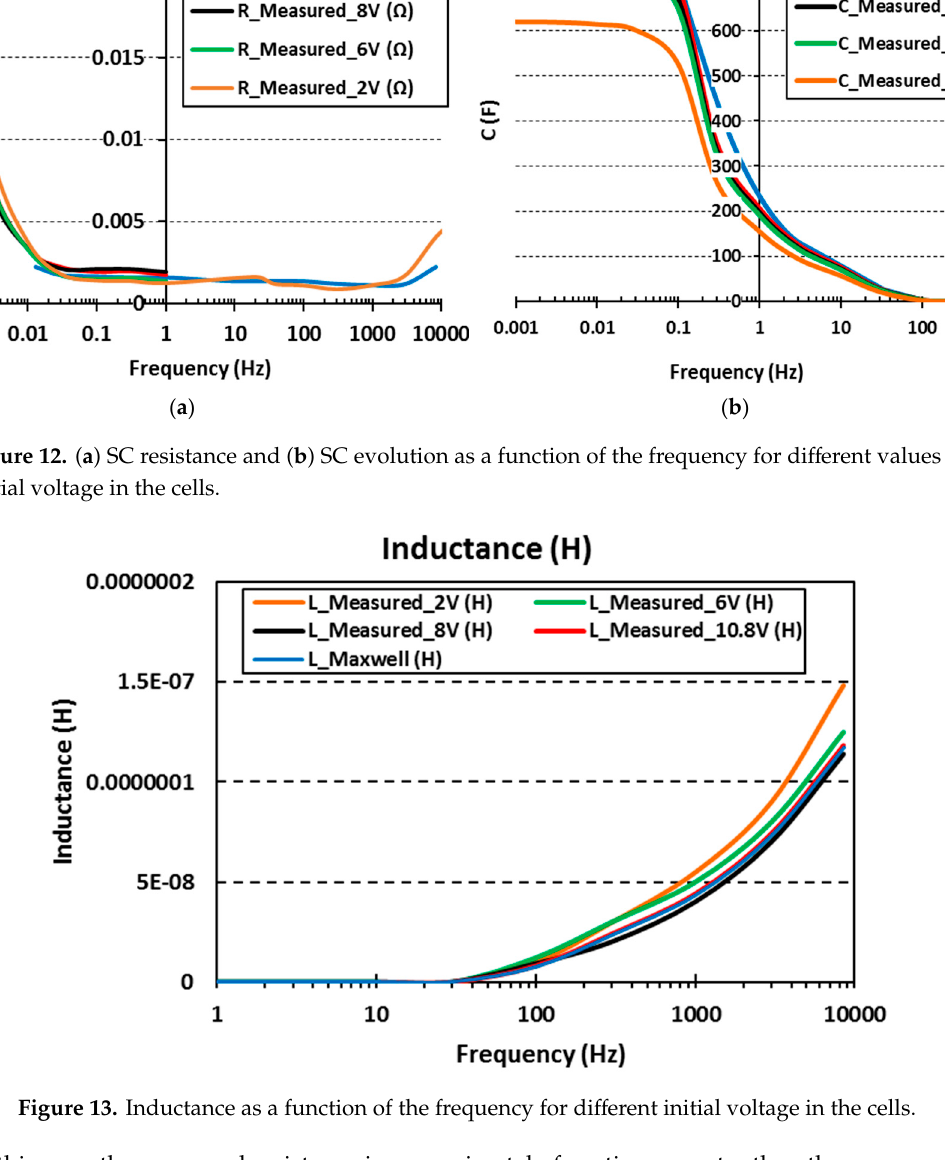
Figure 13. inductance as a function of the frequency for different initial voltage in the cells.